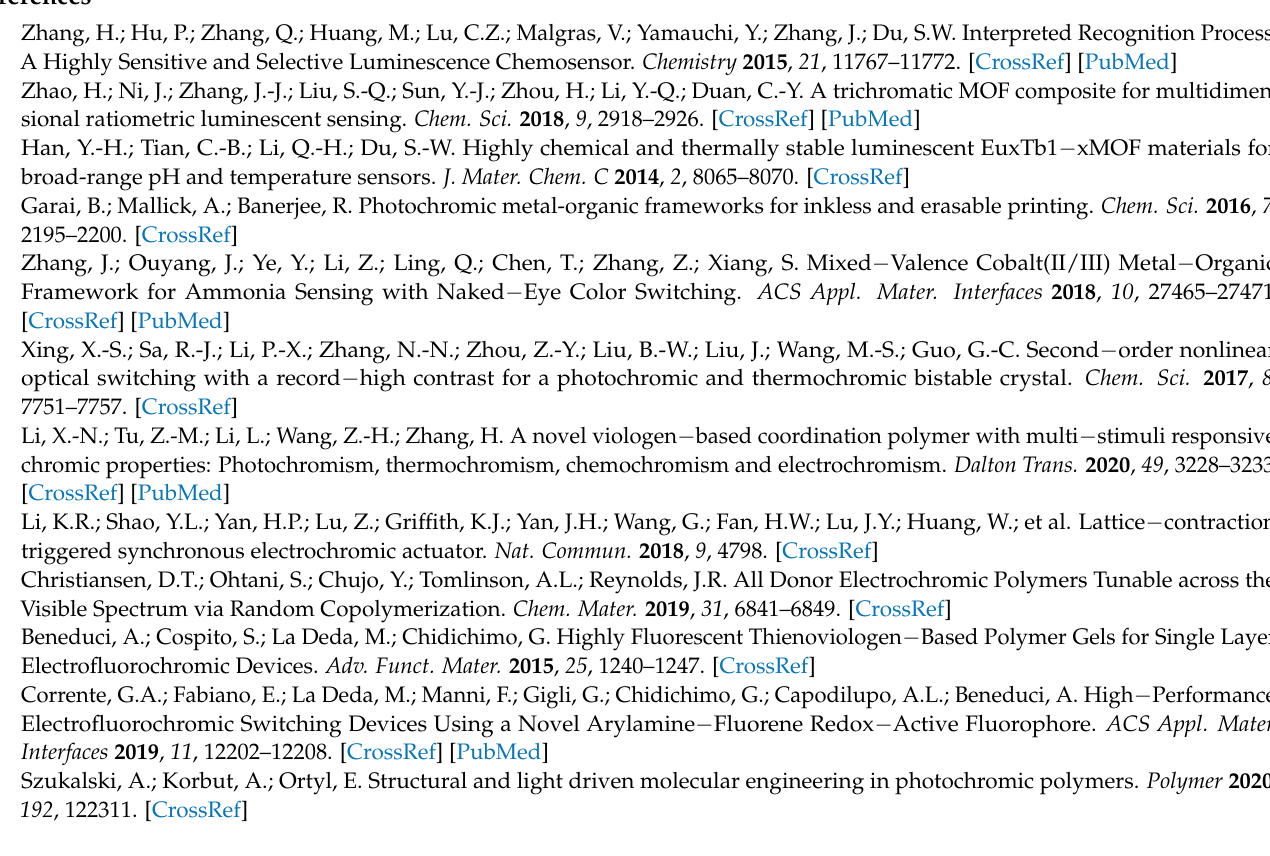
spectrum of the Oxv ligand. Figure S6: The MS spectrum of the Oxv ligand. Figure S7: The TGA − DSC spectrum of the Oxv ligand. Figure S8: High − resolution XPS spectra of Zn 2p, C 1s and N 1s for the Zn − Oxv. Figure S9: The TGA curve of Zn − Oxv CPs. Figure S10: Fluorescence spectra of Zn − Oxv sample. Figure S11: Solid − state UV − vis spectra of free ligand (Oxv) before and after irradiation. Figure S12: Emission spectra of free ligand (Oxv) before and after irradiation. Figure S13: FTIR spectra of Zn − Oxv compound before and after